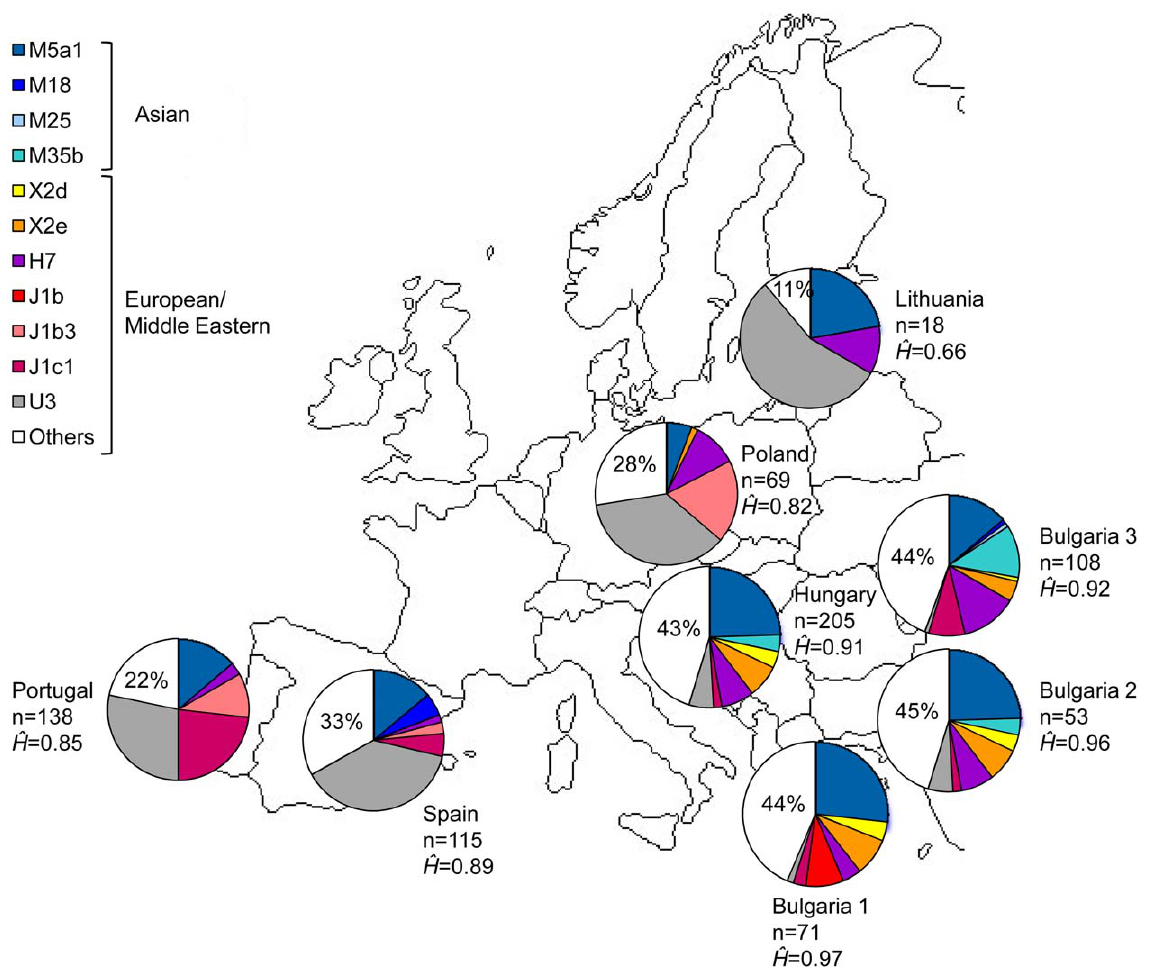
Figure 1. MtDNA haplogroups corresponding to founder lineages in the European Roma populations. Percentages of non-founder lineages are shown in white in the circles. Sample sizes (n) and sequence diversity (Hˆ) are shown for each Roma sample.